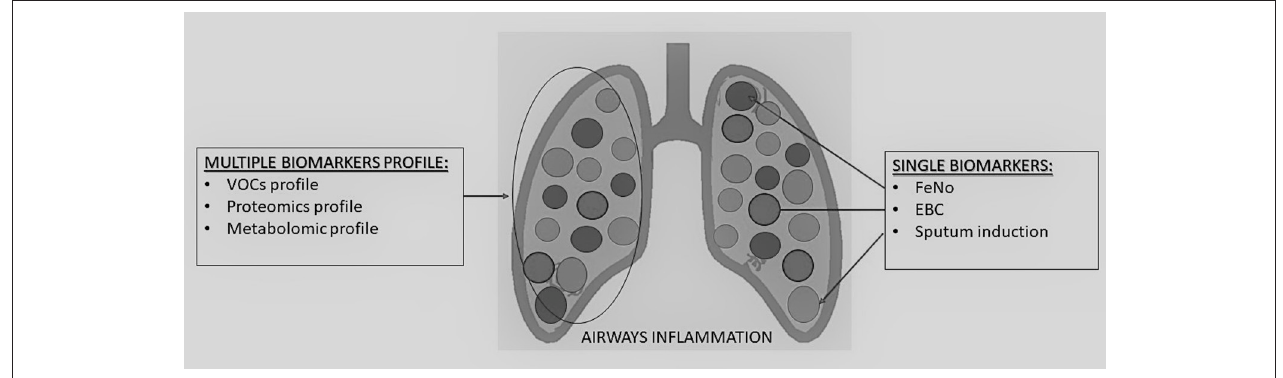
FIGURE 1 | Summary of single and multiple biomarkers detection methods to assess airways inflammation in